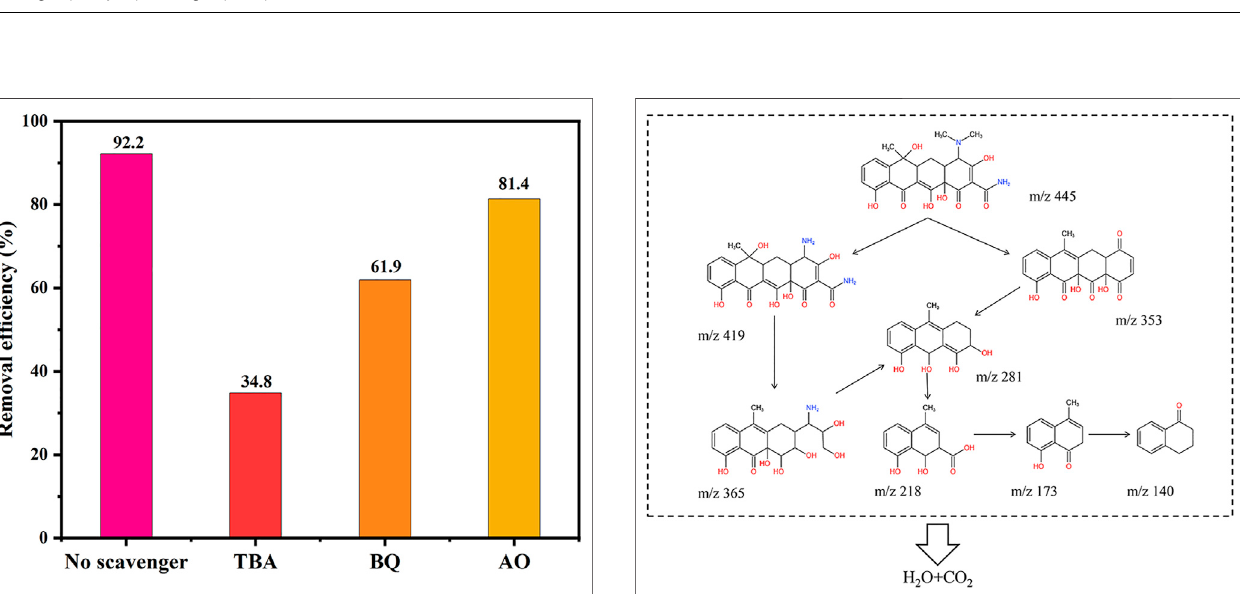
Frontiers in Chemistry |